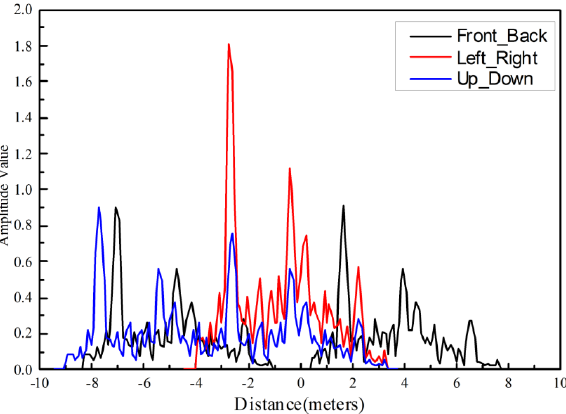
Figure 8. The HRRP image of two missile−like targets with different location distribution.